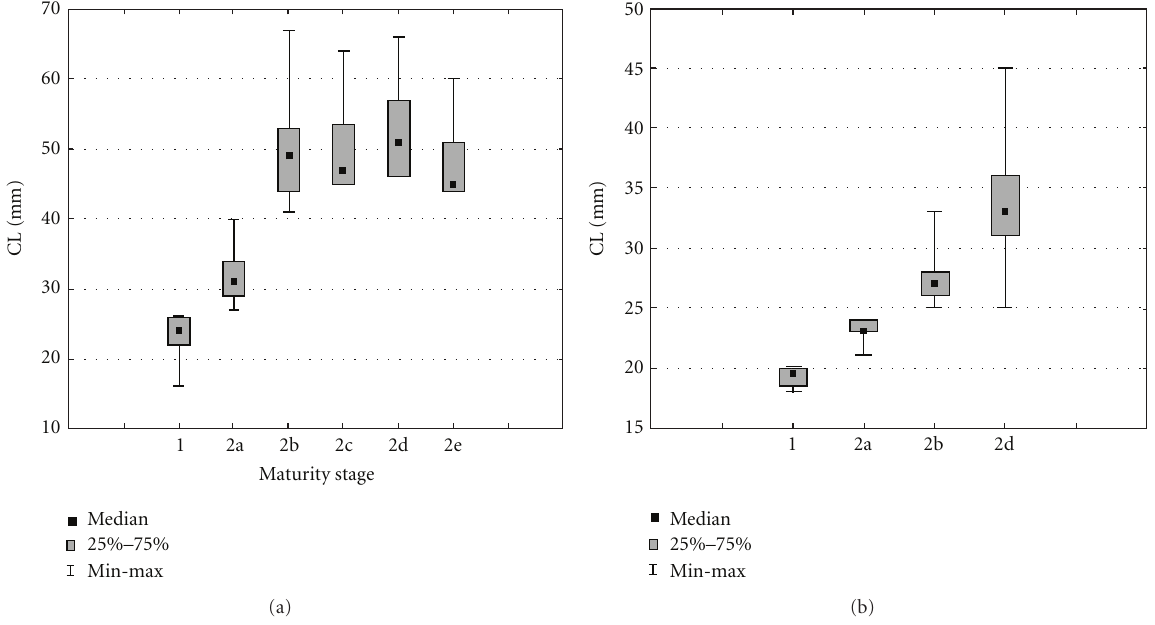
Figure 4: Overall (all months combined) box-plot representation of length structure by sex (females, (a) and males, (b)) and maturity stage in Aristaeomorpha